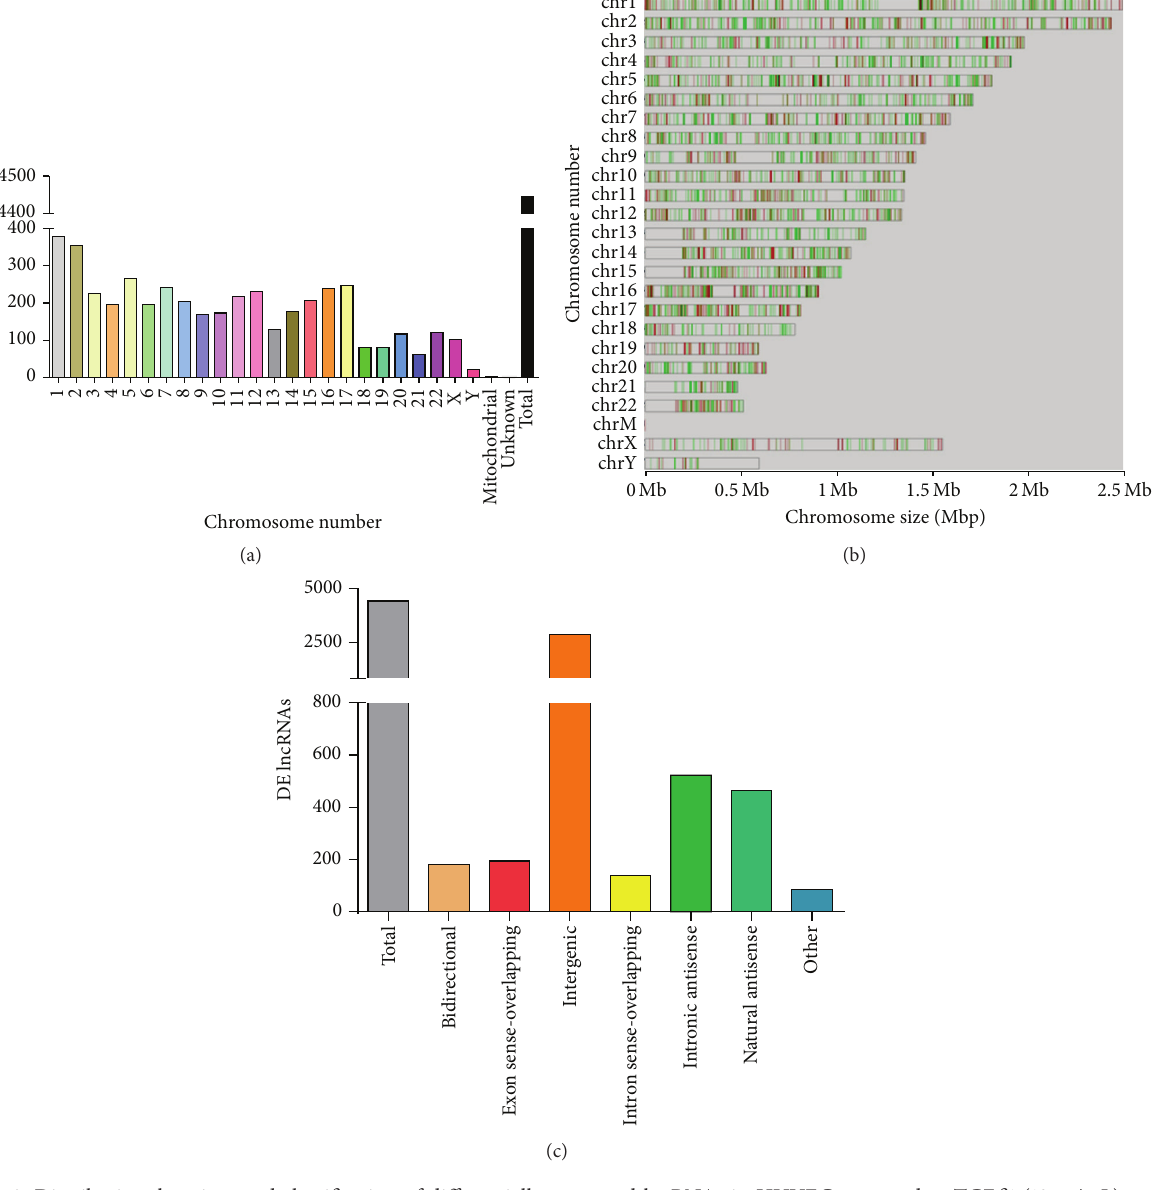
Figure 2: Distribution, location, and classification of differentially expressed lncRNAs in HUVECs exposed to TGF 𝛽 1 (10ng/mL) versus control. Demonstration of (a) numbers and (b) chromosomal location of differentially expressed (DE) lncRNAs on different chromosomes. (c) Bar graph representing types of differently expressed lncRNAs, depending on their genomic